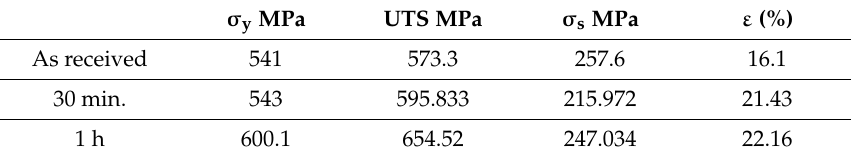
Figure 7. Strain–stress curve for different ageing treatment times of API X-70 steel. Table 6. Results of the tension test for diffeent ageing treatment times of API X-70 steel.